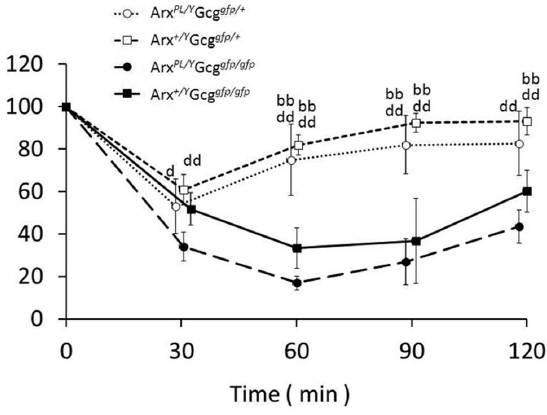
Figure 2. Insulin tolerance tests in glucagon/Arx-PL double mutant mice. Insulin tolerance test was performed using Gcg gfp/ + Arx + / Y , Gcg gfp/ + Arx PL/Y , Gcg gfp/gfp Arx + /Y and Gcg gfp/gfp Arx PL/Y mutant mice. Open circles, Gcg gfp/ + Arx + /Y ; open squares, Gcg gfp/ + Arx PL/Y ; closed circles, Gcg gfp/gfp Arx + /Y ; closed squares, Gcg gfp/gfp Arx PL/Y . ‘bb’ vs Gcg gfp/gfp Arx + /Y , P , 0.01; ‘d’ vs Gcg gfp/gfp Arx PL/Y , P , 0.05; ‘dd’ vs Gcg gfp/gfp Arx PL/Y , P , 0.01.